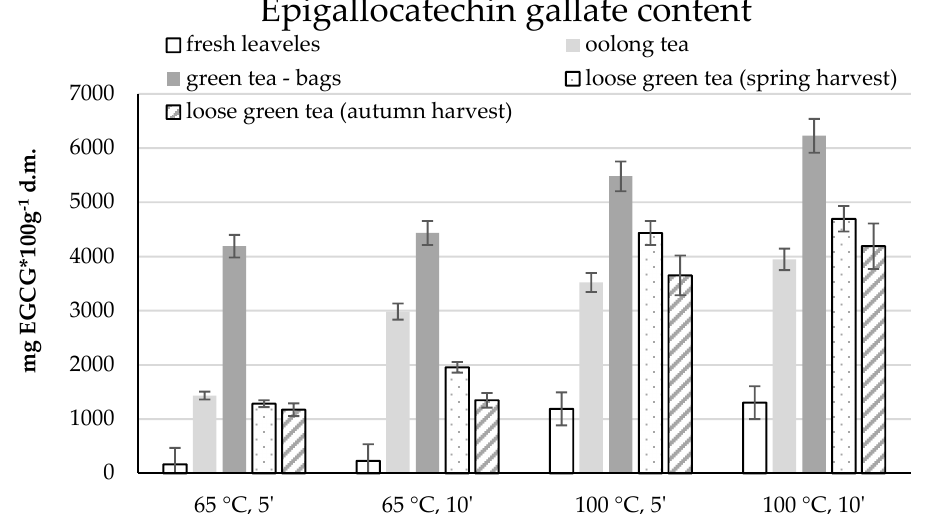
Figure 5. Epigallocatechin gallate content in water infusions of tea shrub leaves and various types of teas depending on the brewing parameters.